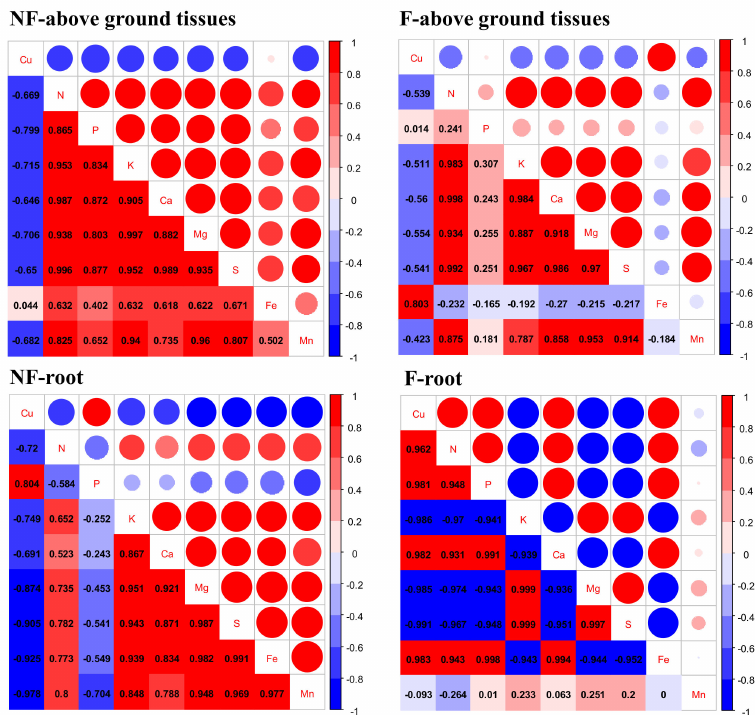
Figure 4. Pearson’s correlation analysis performed on element concentrations measured in the above- ground parts and roots in of S. integra and S. jiangsuensis exposed to Cu-contaminated soil under non-flooded and flooded conditions for 90 d. (Positive correlations are displayed in red and negative correlations in blue color. Color intensity and circle size are proportional to the correlation